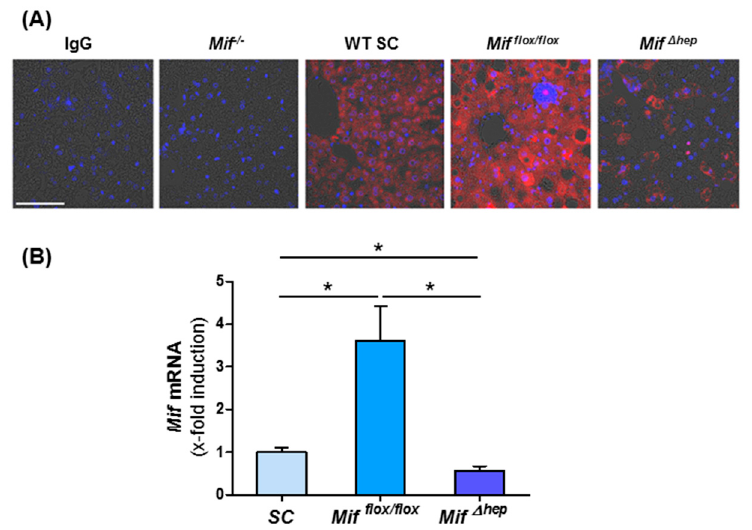
Figure 3. Hepatocytes are the main source of MIF in the liver. ( A ) Representative immunofluorescence stainings of WT mice after standard chow and after 8 weeks of MCD diet-induced NASH. IgG serves as antibody control and tissue from Mif − / − and Mif ∆ hep mice after 8 weeks of MCD diet serves as negative control (Scale bar 50 µm). ( B ) Mif mRNA expression in Alfp-cre negative Mif flox / flox mice after MCD diet in contrast to standard chow fed WT mice and mRNA level of Mif in Mif Δ hep mice of total liver lysates after 8 weeks of MCD diet compared to Mif flox / flox mice were determined via qRT-PCR ( n = 6 per group). Asterisks indicate statistical significance: * p <